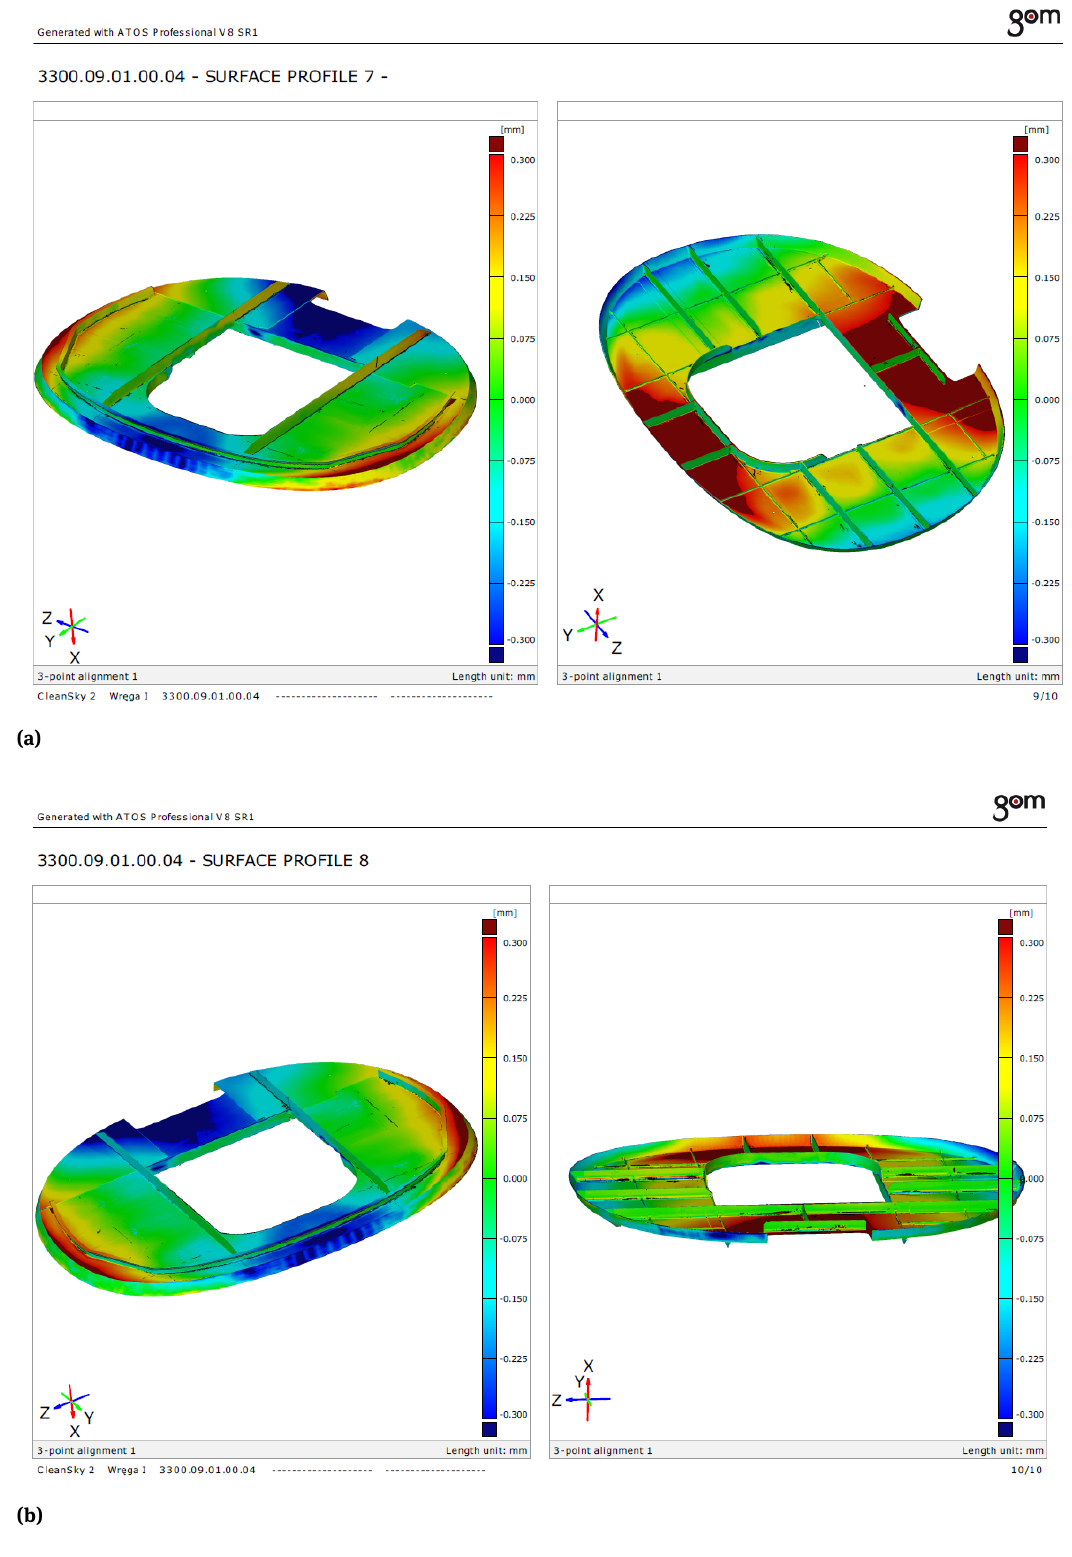
Figure 5: The maps of the linear dimensions and displacements of the frame elements after the mechanical